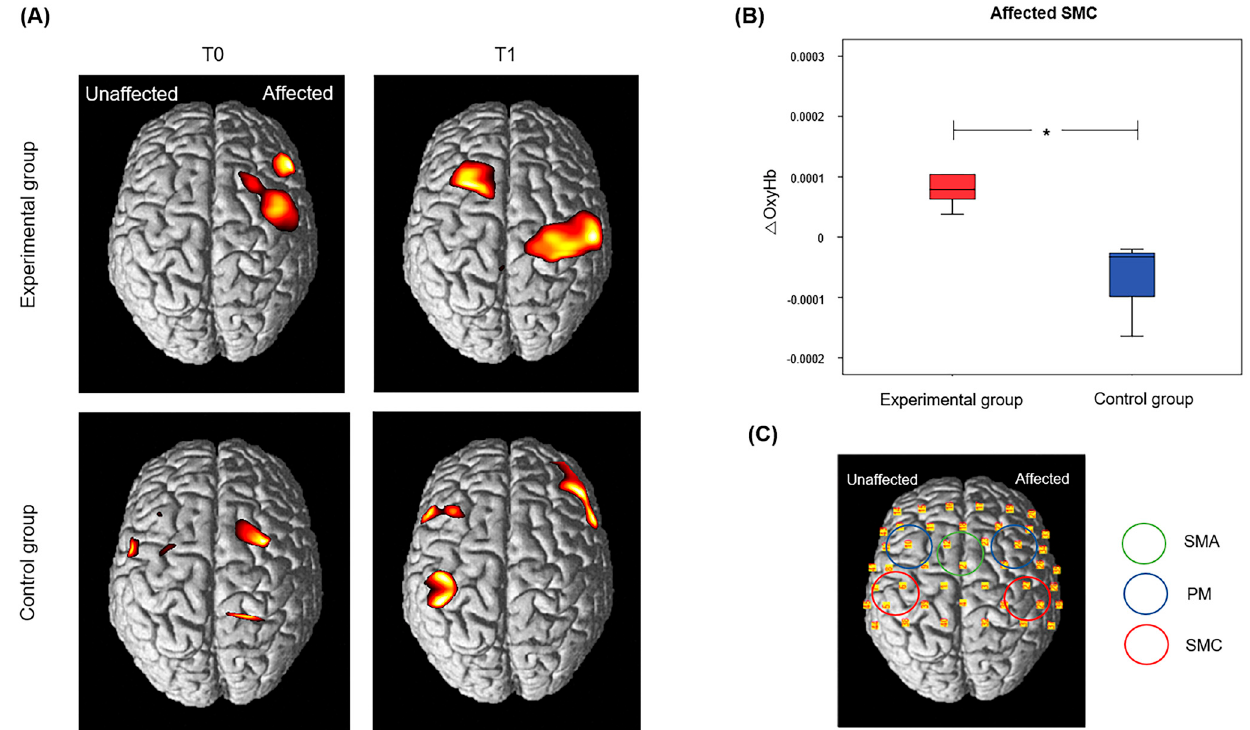
Figure 4. The results of group analysis of oxygenated hemoglobin in experimental and control groups during affected wrist movement. ( A ) Group-average activation map of OxyHb. ( B ) Changes in oxygenated hemoglobin concentration ( ∆ OxyHb) in the affected primary sensorimotor cortex at T1. ( C ) fNIRS channel montage and affected cortical areas. T0: before the intervention; T1: immediately after the intervention; OxyHb: oxygenated hemoglobin; SMC: primary sensorimotor cortex; PMC: premotor cortex; SMA: supplementary motor area. * p < 0.01 for between-group comparison (Mann-Whitney U test).